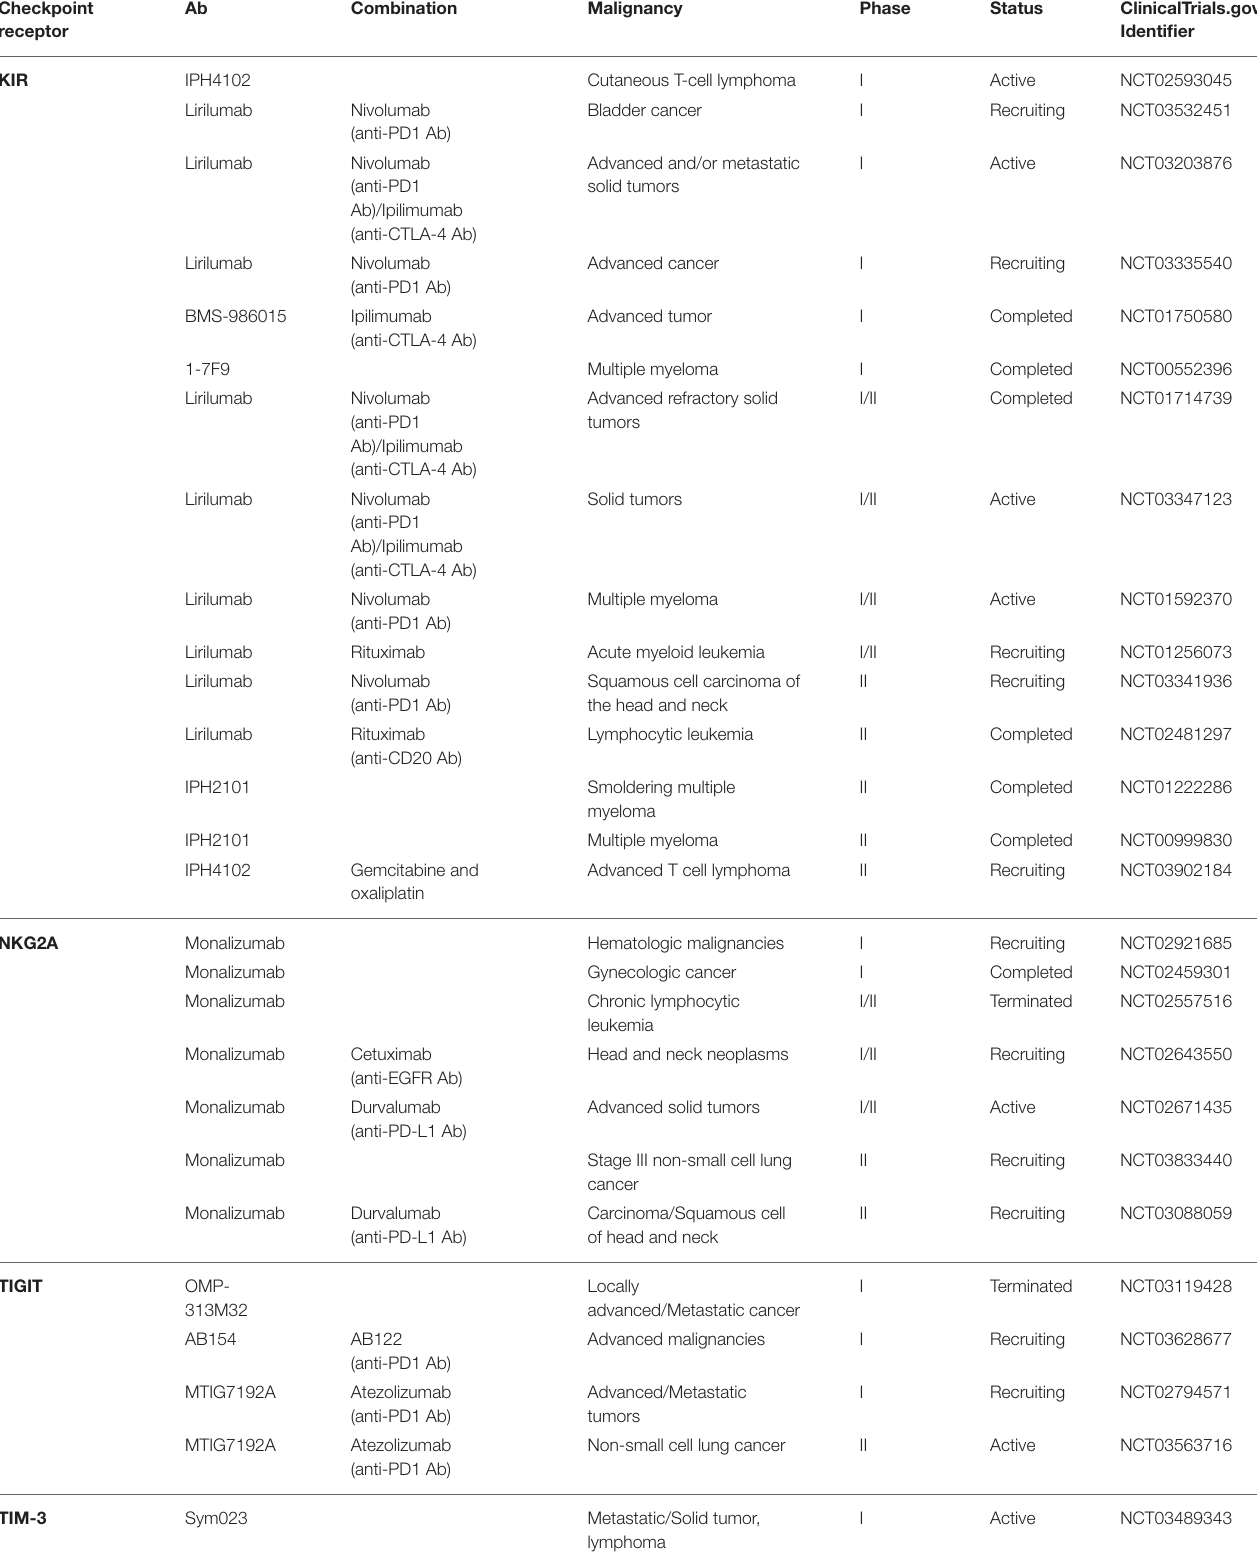
TABLE 1 | Current clinical trials based on NK cell checkpoint receptors or molecules. Checkpoint